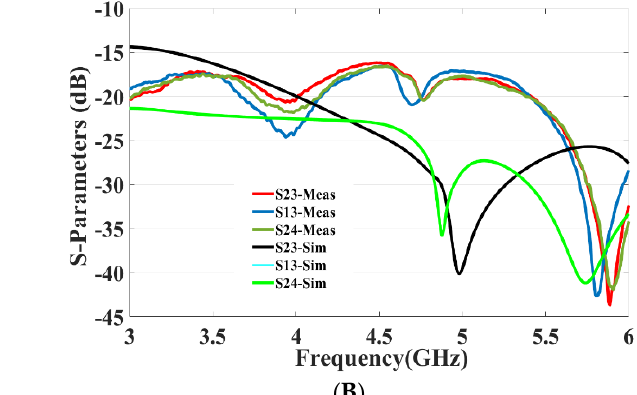
Figure 7. MIMO antenna measurement setup in an anechoic chamber.